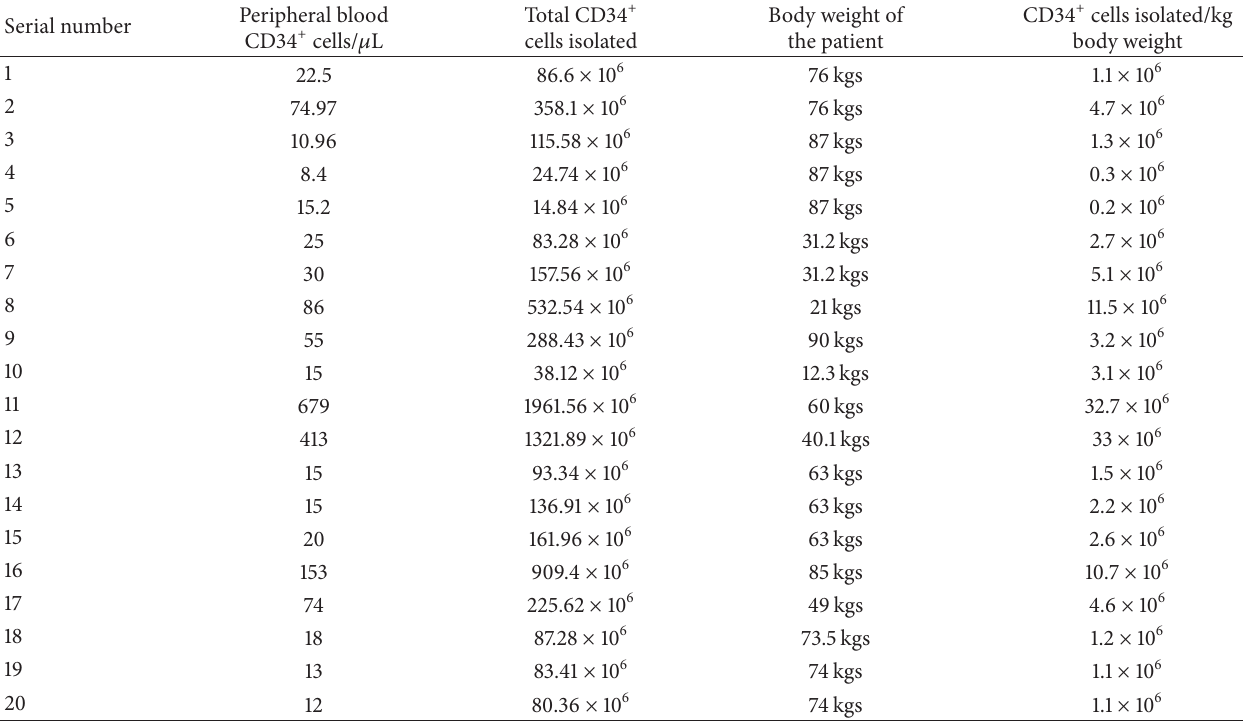
Table 1: Comparison study of the enumeration of stem cells isolated from peripheral blood from the donor, the body weight of the patient, and the total CD34 + cells